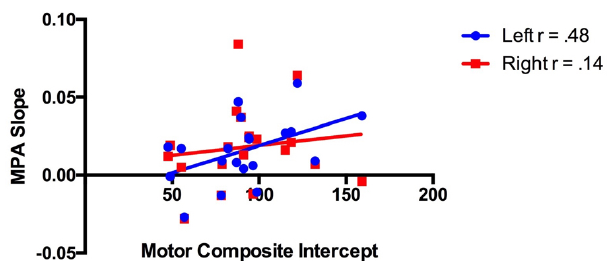
Figure 16. Scatter plot of mean peak acceleration (MPA) slopes (for right and left arms) and Bayley composite motor intercepts of each